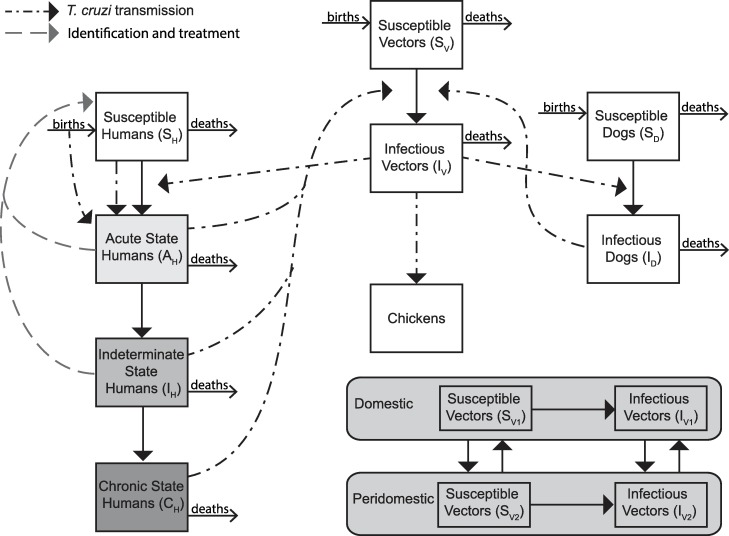
Transmission model structure.Deaths include Chagas related mortality in the acute and chronic states. Identification and treatment for states varies by scenario.